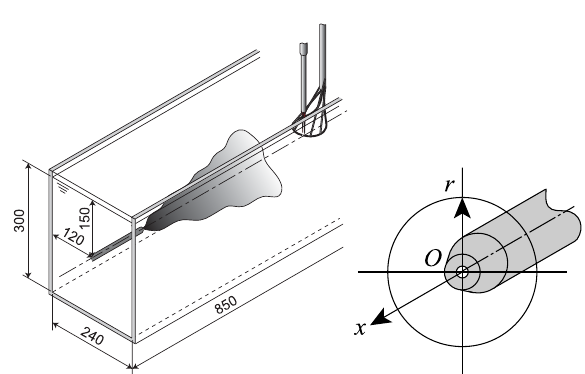
Fig. 1 Schematic of the experimental apparatus and coordinate system